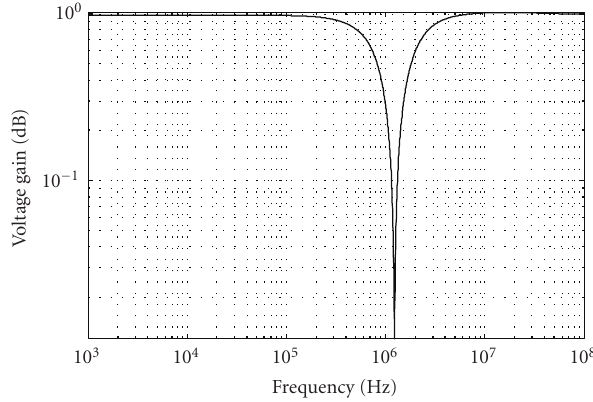
Figure 12: Frequency response of BRF using simulated floating inductor.